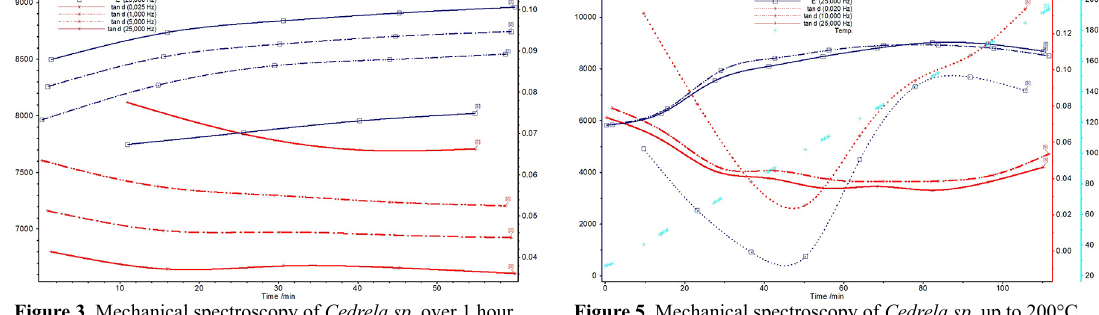
Figure 3. Mechanical spectroscopy of Cedrela sp . over 1 hour.